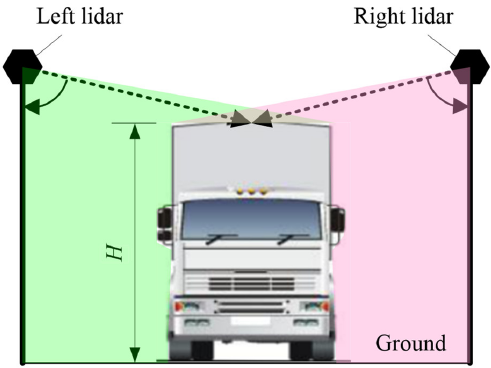
Figure 9. Illustration of how to measure vehicle height.